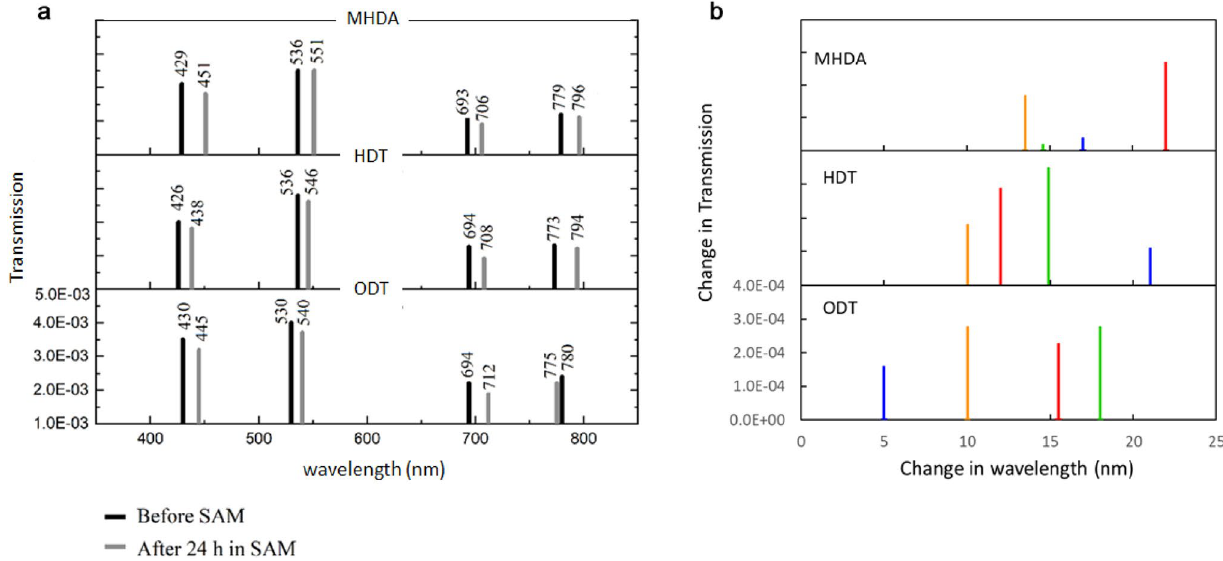
Figure 7. Optical barcodes for SAMs ( a ) ‘before SAM’ (vertical black lines) and ‘after SAM’ (vertical grey lines) and ( b ) position and transmission of isosbestic points for MHDA, HDT, and